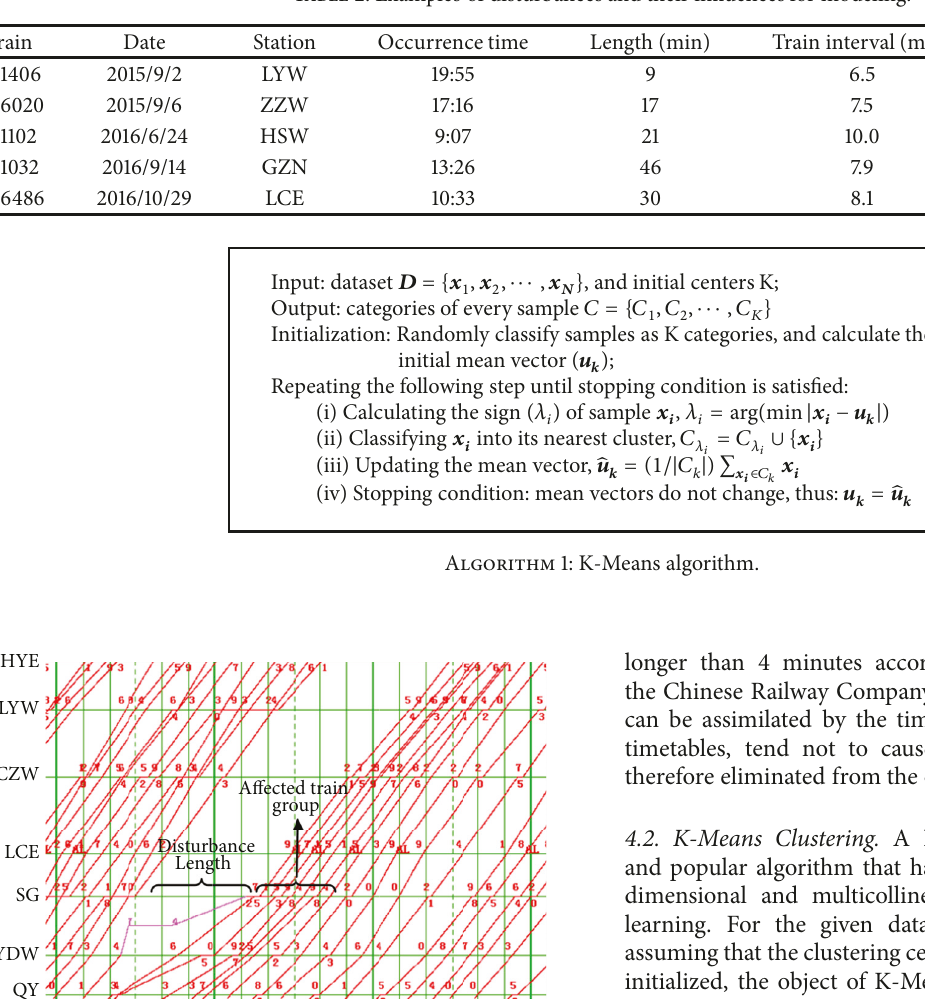
Table 2: Examples of disturbances and their influences for modeling.